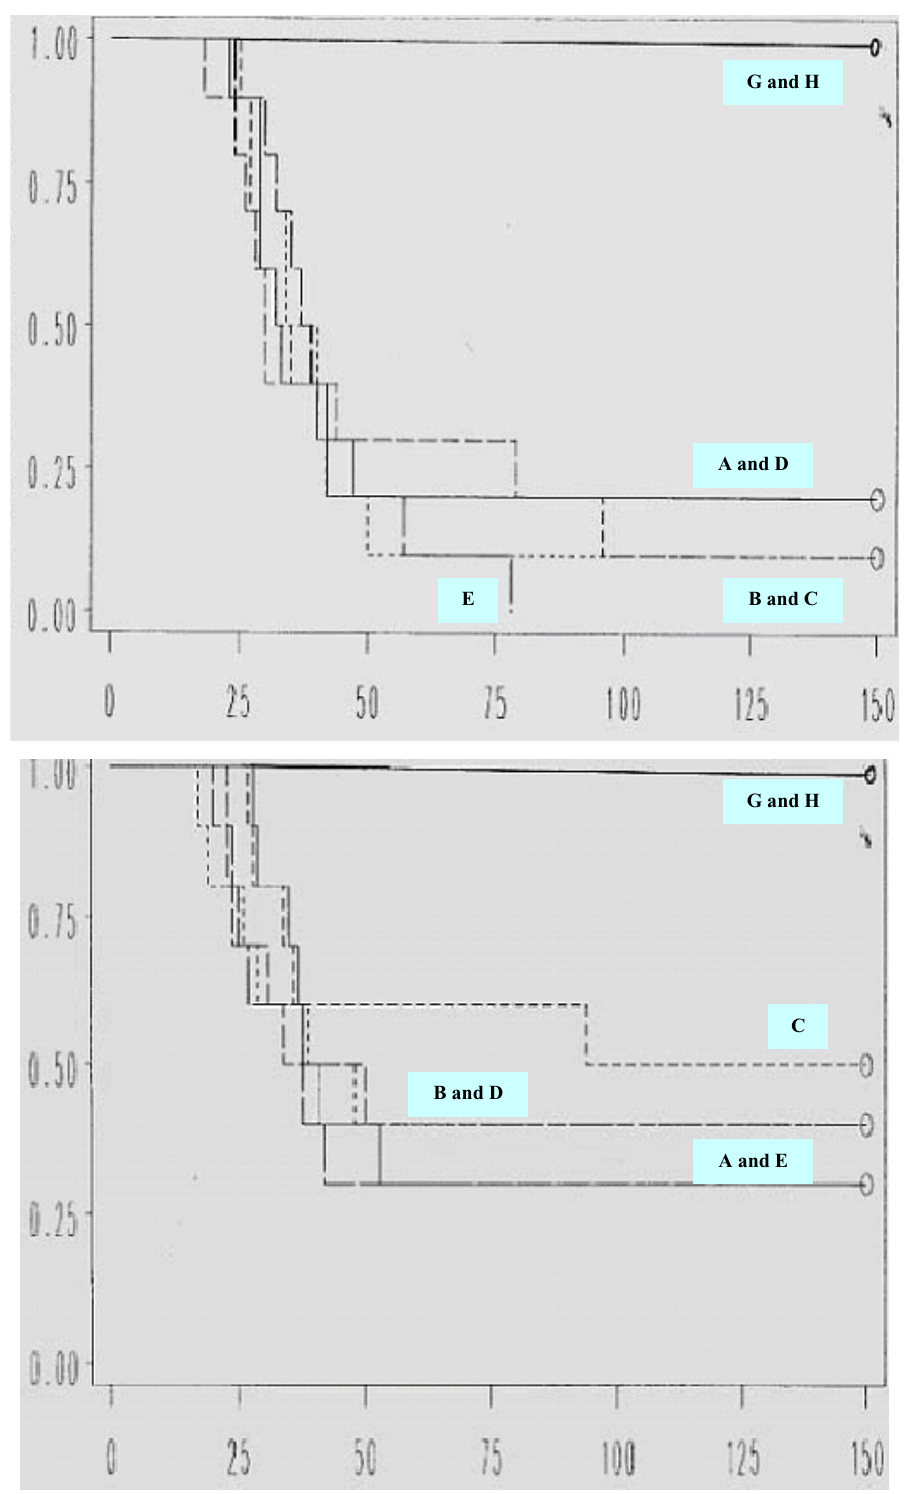
Figure 3. Survival distribution function curves of animals injected with LQQ venom (250 (cid:80) g.kg -1 , s.c.) and verapamil at a dose of either ( I ) 0.03 mg.kg -1 or ( II ) 0.1 mg.kg -1 . The Y-axis represents survival distribution, with (0) indicating death and (1) survival, while the X-axis represents survival time in minutes. ( A ) LQQ venom alone, ( B ) V administered 3 min before, ( C ) 1 min, ( D ) 5 min, and ( E ) 15 min after LQQ venom. As control, ( G ) V and ( H ) 0.9%NaCl were administered